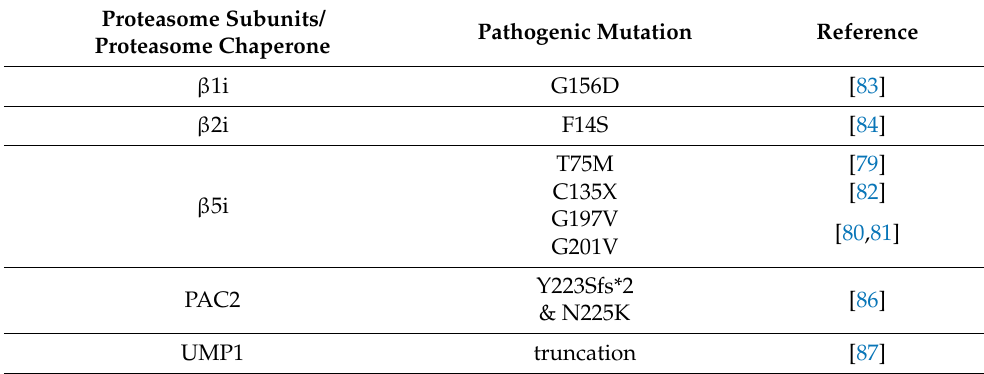
Table 1. Pathogenic mutations in the proteasome subunits and proteasome assembly chaperones. Proteasome